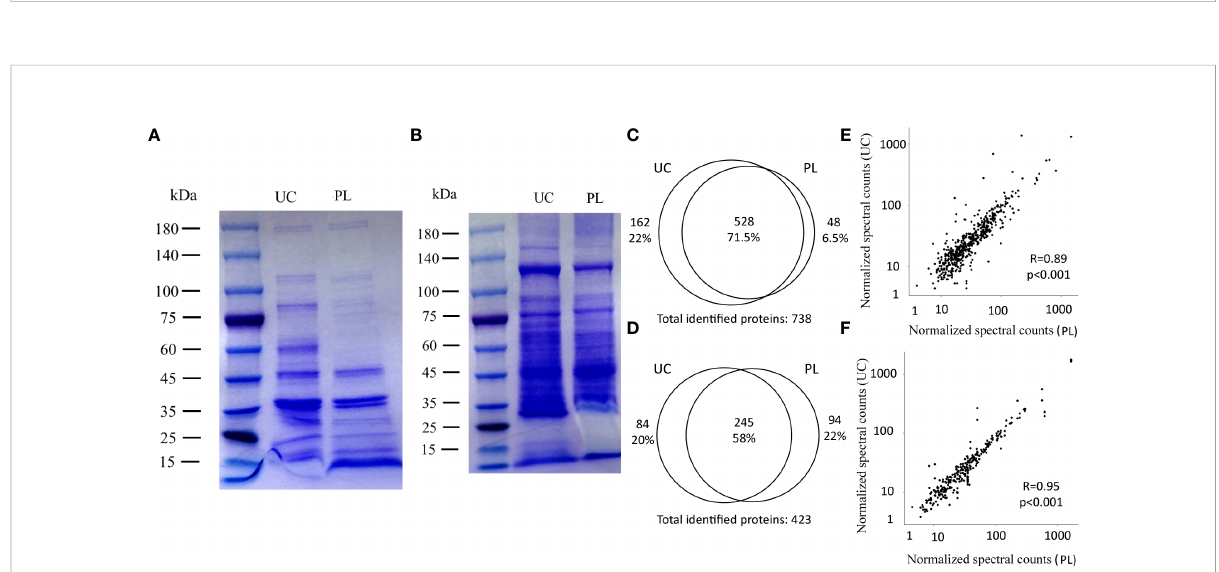
FIGURE 3 Comparison of identi fi ed proteins between UC and PL. SDS-PAGE of BEVs derived from E. coli (A) and S. aureus (B) isolated by UC and PL. Venn diagrams showing the identi fi ed proteins in E. coli (C) and S. aureus (D) BEVs isolated by UC or PL. Correlation analysis of proteins identi fi ed in E. coli (E) and S. aureus (F) BEVs isolated by UC compared to PL. Shown proteins were identi fi ed in at least 2 of the 4 patients in each